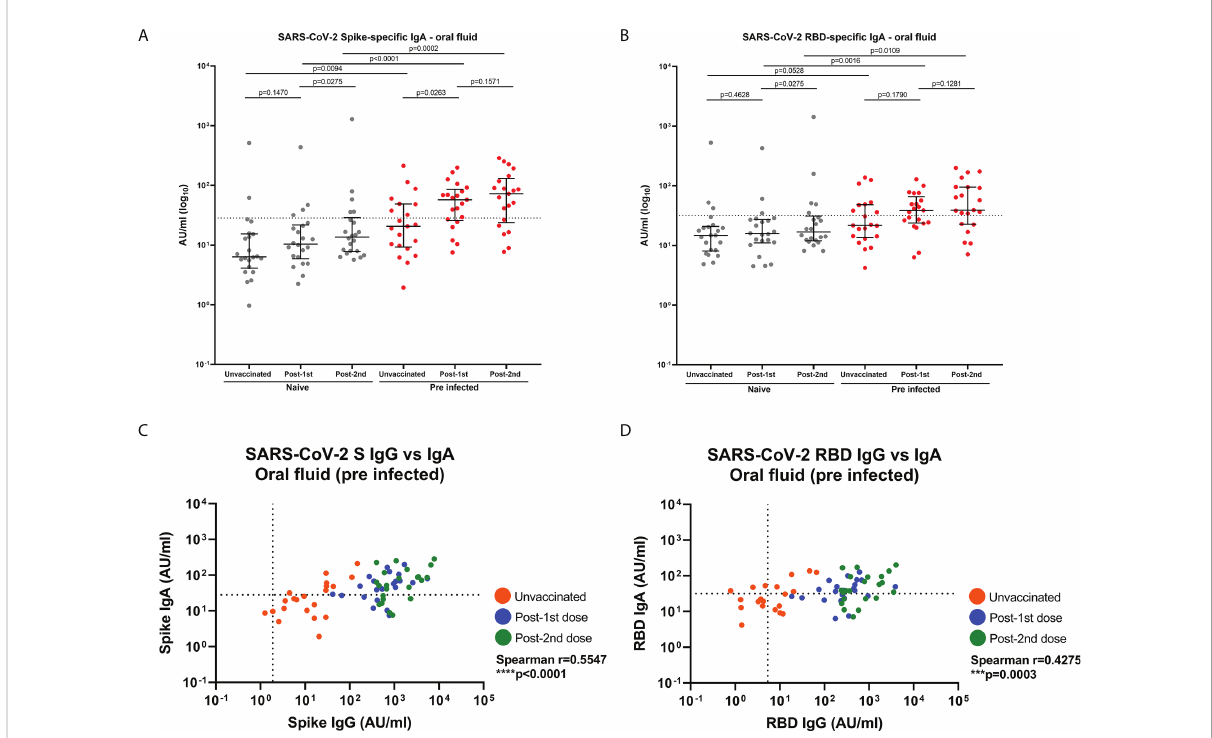
FIGURE 5 SARS-CoV-2 S- and RBD-speci fi c IgA responses and correlations with IgG responses in oral fl uid. SARS-CoV-2 speci fi c IgA concentrations in matched oral fl uid from naïve and previously-infected individuals determined by multiplex MSD ® immunoassay. (A) S-speci fi c IgA and (B) RBD- speci fi c IgA in oral fl uid. Wilcoxon and Mann-Whitney tests were used to determine the statistical signi fi cance between the groups of paired and unpaired samples, respectively. Dashed lines show the cut-offs based on IgA responses in 22 unvaccinated naïve samples (average concentration +1SD). Correlations between SARS-CoV-2 S- (C) and RBD-speci fi c (D) IgG versus IgA concentrations in oral fl uid from previously-infected individuals. Pairwise correlations were assessed using Spearman ’ s rank-order correlation. ****=p-value <0.0001; ***=p- value